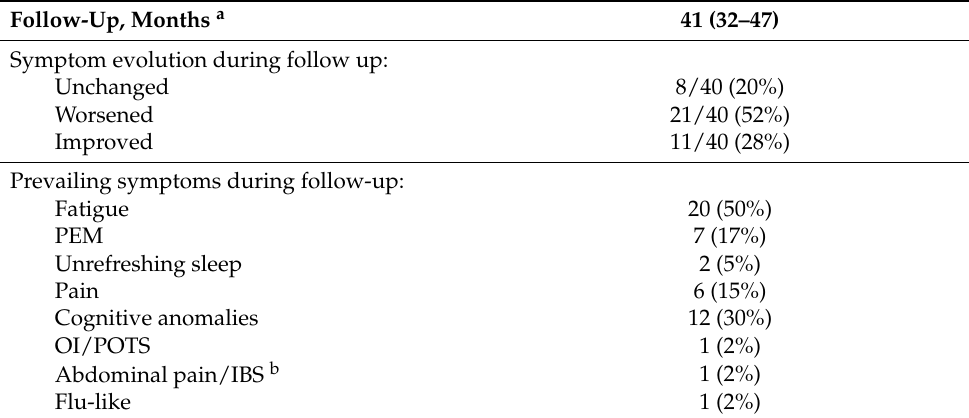
Table 3. Follow-up clinical information of the 40 ME/CFS